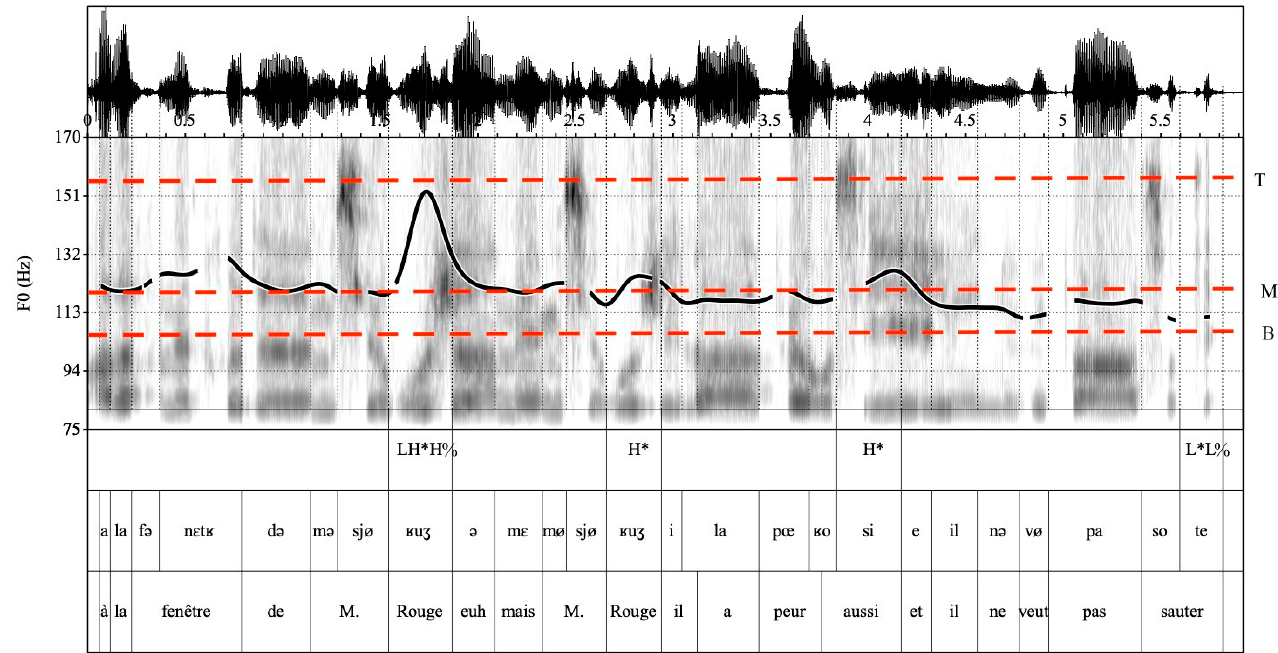
Languages 2021 , 6 , x FOR PEER REVIEW 19 of 22